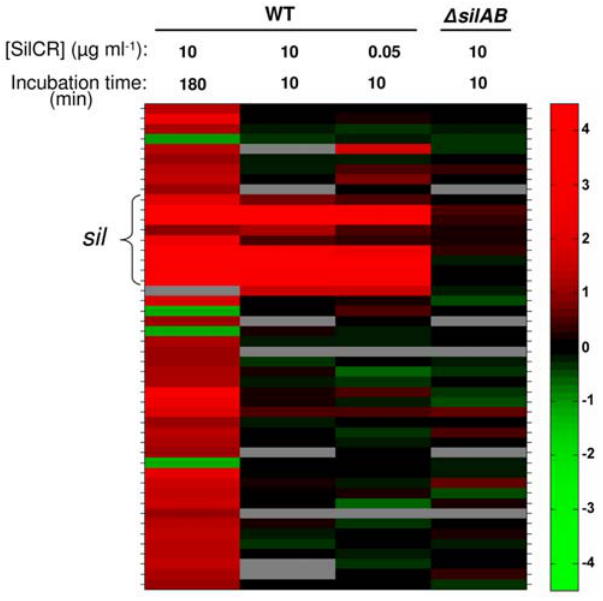
Figure 5. Global transcriptional analysis of JS95 in the presence of SilCR. To identify genes whose transcription is affected by SilCR, we exposed strain JS95 and its D silAB mutant to the conditions specified, and performed transcriptome analyses using a ‘‘universal’’ GAS microarray, as detailed in ‘‘Materials and Methods’’. The results represent gene loci whose expression ratio changed by 2-fold or more with a p-value , 0.05, at least in one of the experiments, visualized using the MatLab software. The genes are ordered vertically, based on their position in the genome (NC_008024) of M4-type strain MGAS10750 containing sil . The 9 genes of sil locus are indicated by a bracket. Grey bars represent cases when the replicate probes were highly inconsis- tent. For numerical values of the presented data and gene names see Table S5. The data is also available in NCBI Gene Expression Omnibus (GEO) (accession no